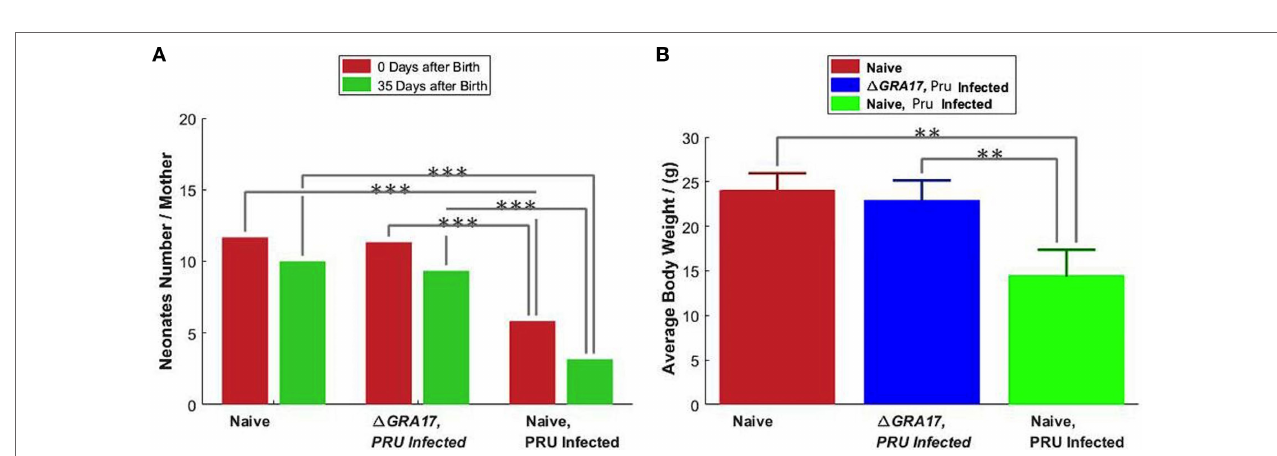
FigUre 9 | Protection of mice against type I RH tachyzoite infection on day 18 of gestation. (a) The litter size of pups from the non-immunized and uninfected mice (naïve); non-immunized and RH-infected mice, and immunized and RH-infected mice was assessed at birth and 5 days after birth. (B) The body weight of 5-day-old pups. Significance compared with naïve control mice: ** p < 0.01, *** p <